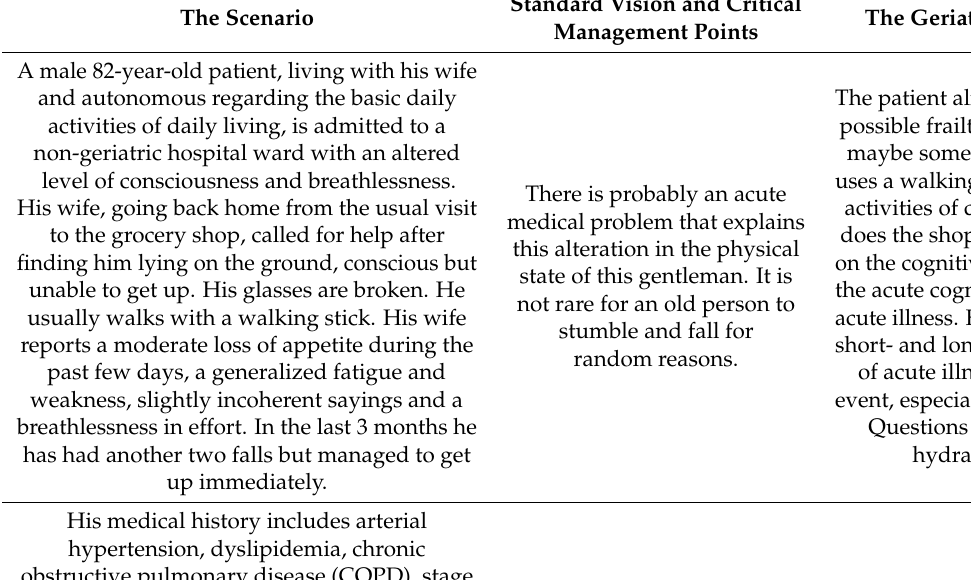
Table 2. Clinical case scenario presenting a rather common case in everyday practice according to the standard management without a “geriatric medicine insight” vs the geriatric medicine approach. Standard Vision and Critical The Scenario The Geriatric Medicine’s Point of Management Points